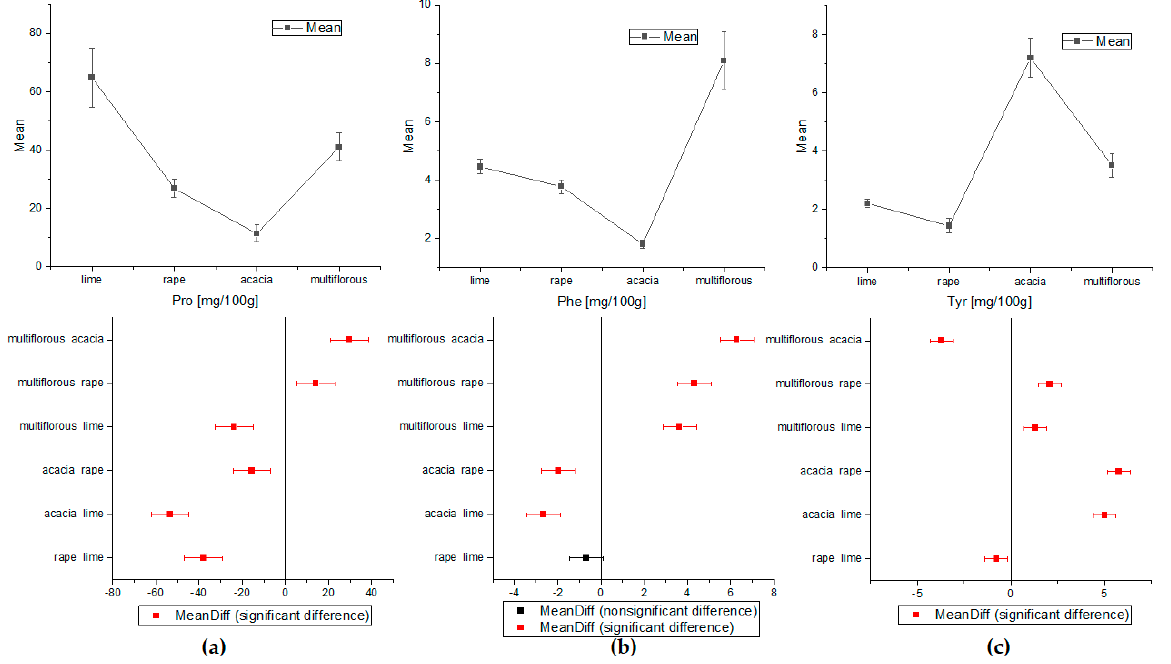
Figure 3. The comparison of the average content of amino acids obtained by ANOVA ( a ) for proline, ( b ) for phenylalanine, and ( c ) for tyrosine (Tukey test, p < 0.05).